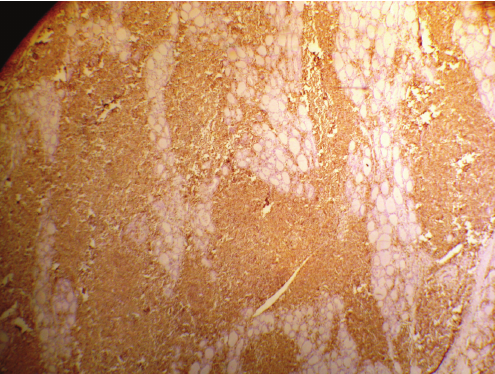
Figure 3: Immunohistochemistry